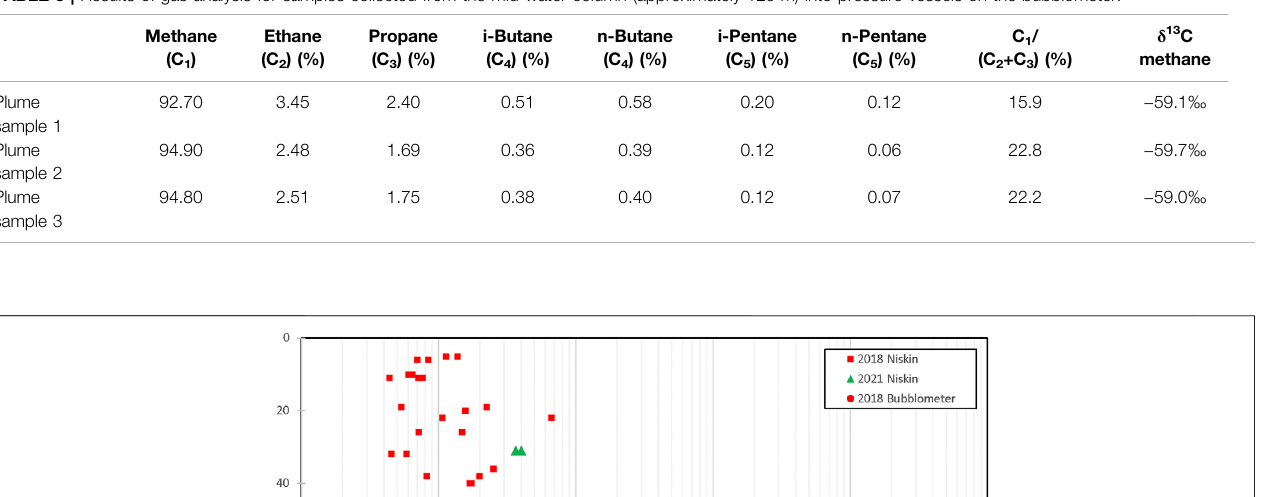
TABLE 3 | Results of gas analysis for samples collected from the mid-water column (approximately 125 m) into pressure vessels on the bubblometer.